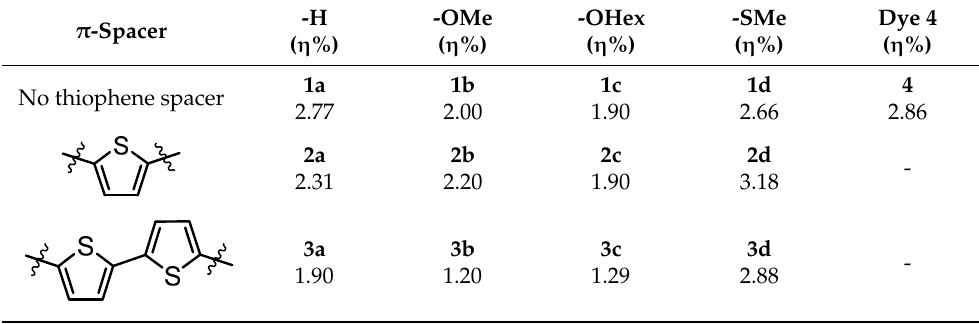
Table 3. Structure-property relationship of TPA-based dyes via their average power conversion efficiency (η%).